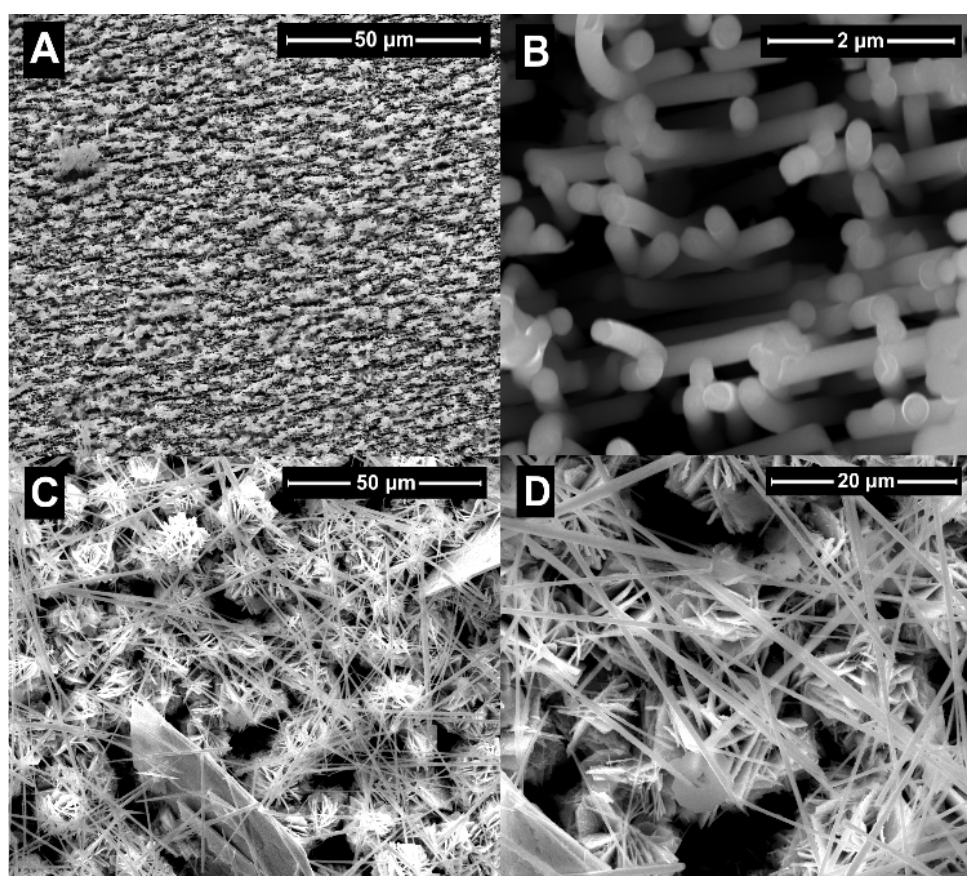
Figure 2. SEM images of lead NWs before ( A , B ) and after the deposition of GO ( C , D ).